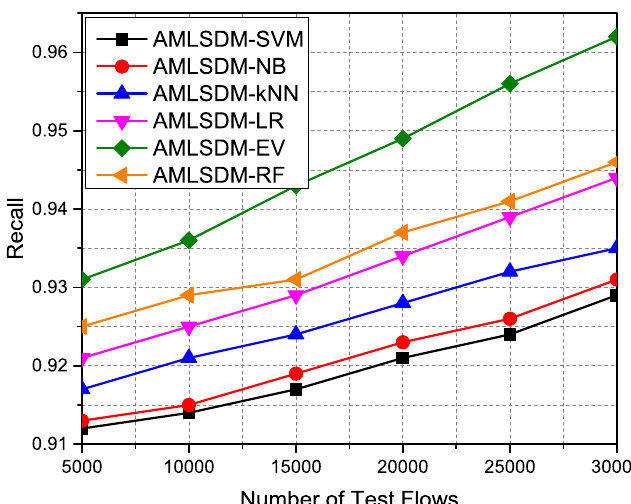
Figure 25. F1-score performance of ML classifiers.